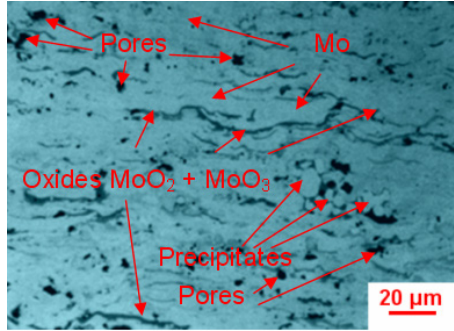
Figure 4 – Microstructure of Mo&O 2 coatings Рис . 4 – Микроструктура Mo&O 2 покрытия Слика 4 – Микроструктура Mo&O 2 превлаке